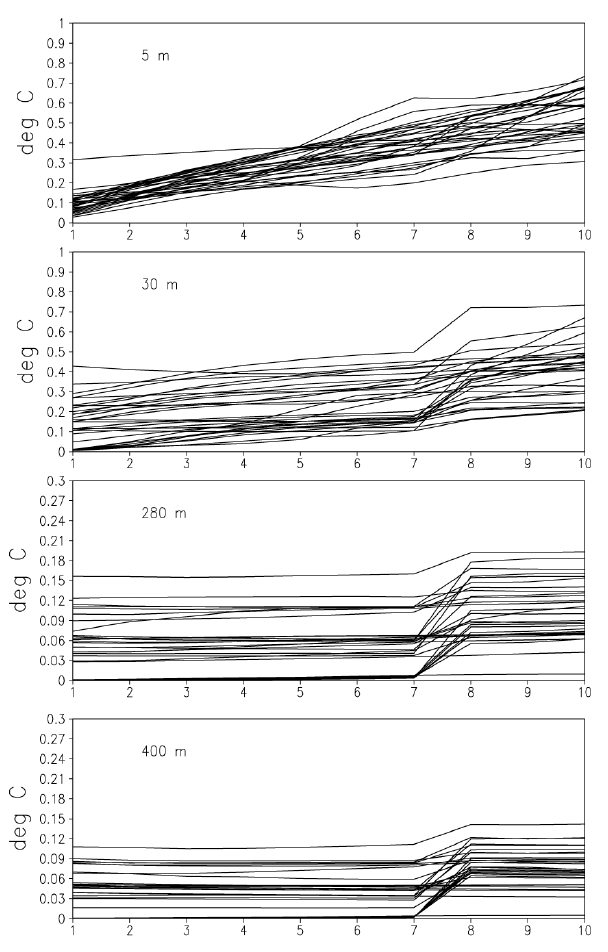
Fig. 8. Root mean square temperature forecast error at (a) 5 m; (b) 30 m; (c) 280 m; and (d) 400 m. Different curves correspond to 31 different 10-day forecasts carried out from April to October 2000.